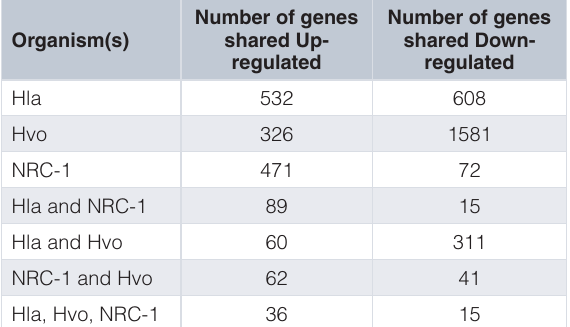
Table 1. Transcripts regulated under growth in alkaline conditions.